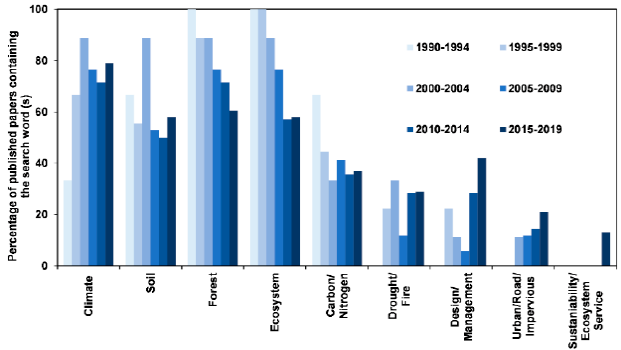
Figure 5. The changing trends of selected words and phrases in RHESSys-related papers.